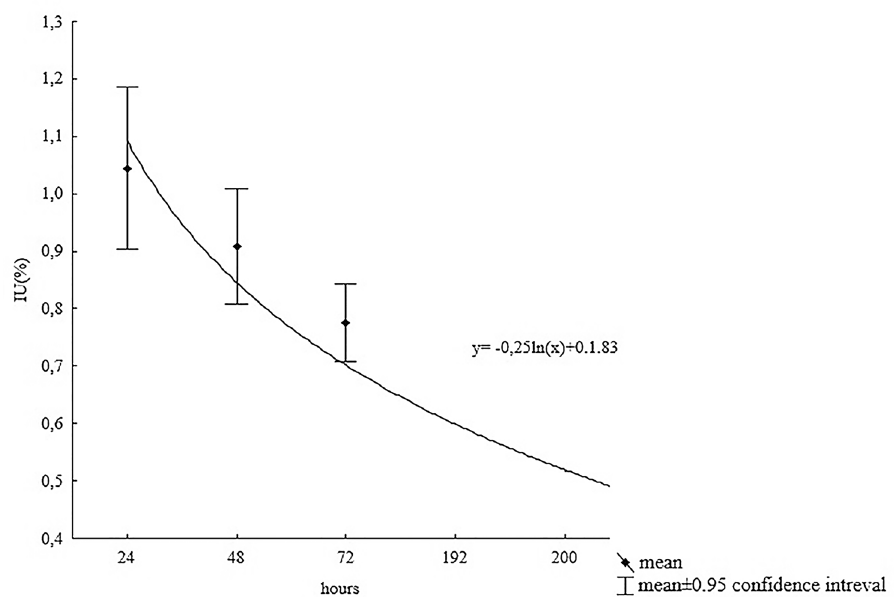
Figure 2. Biokinetics of 131 I (adjusted for physical decay) with assessment of T eff in remnant thyroid in postoperative bed in patients with DTC, obtained from three measurements of IU 24 , IU 48 , and IU 72 ,with the assumption of a nonlinear model: y = − 0.25ln(x) + 0.1.83; ½ IU max = − 0.25ln(x) + 0.183 → x (T eff ) = 192 ± 14.4 h (8.04 ± 0.15 days).